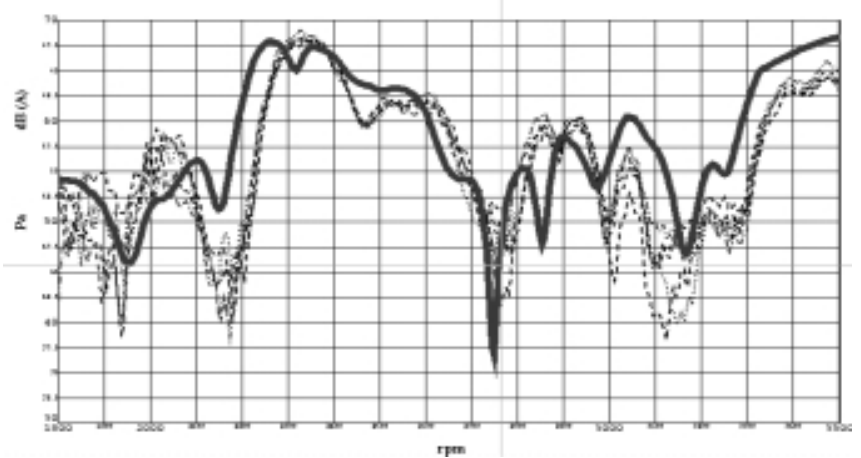
Fig. 11. Sound pressure level at driver’s left ear. Calculated result (solid line) vs. 5 experimentally measured results (dot